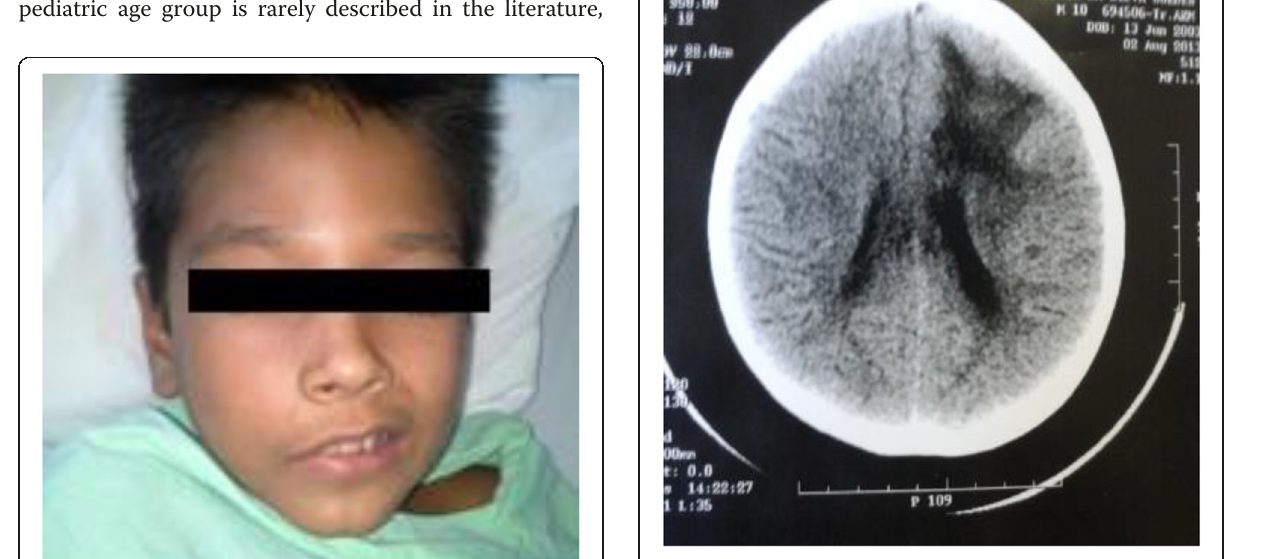
Fig. 4 Cranial computed tomography showing intracerebral hemorrhage in the right frontal area